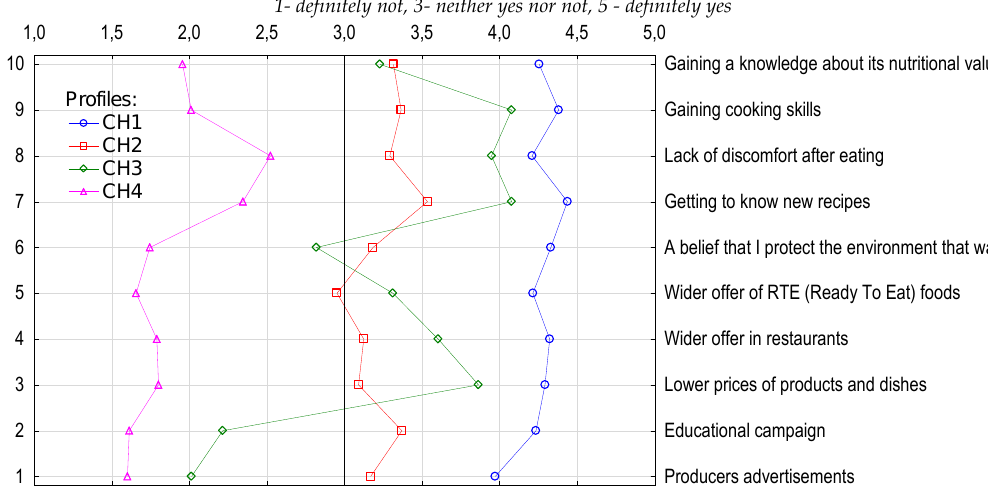
Figure 4. Profiles of respondents based on their statements about chances for pulse consumption.